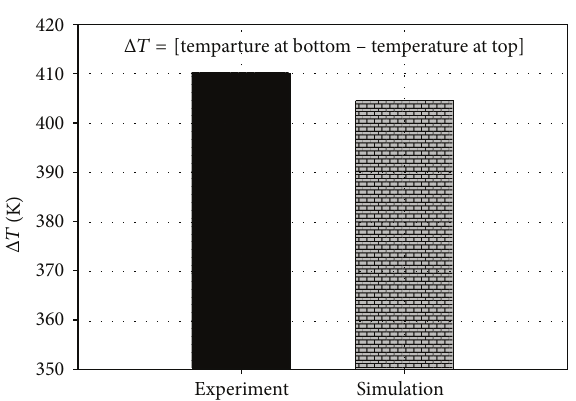
Figure 8: Comparison of Δ𝑇 between experiment and simulation.